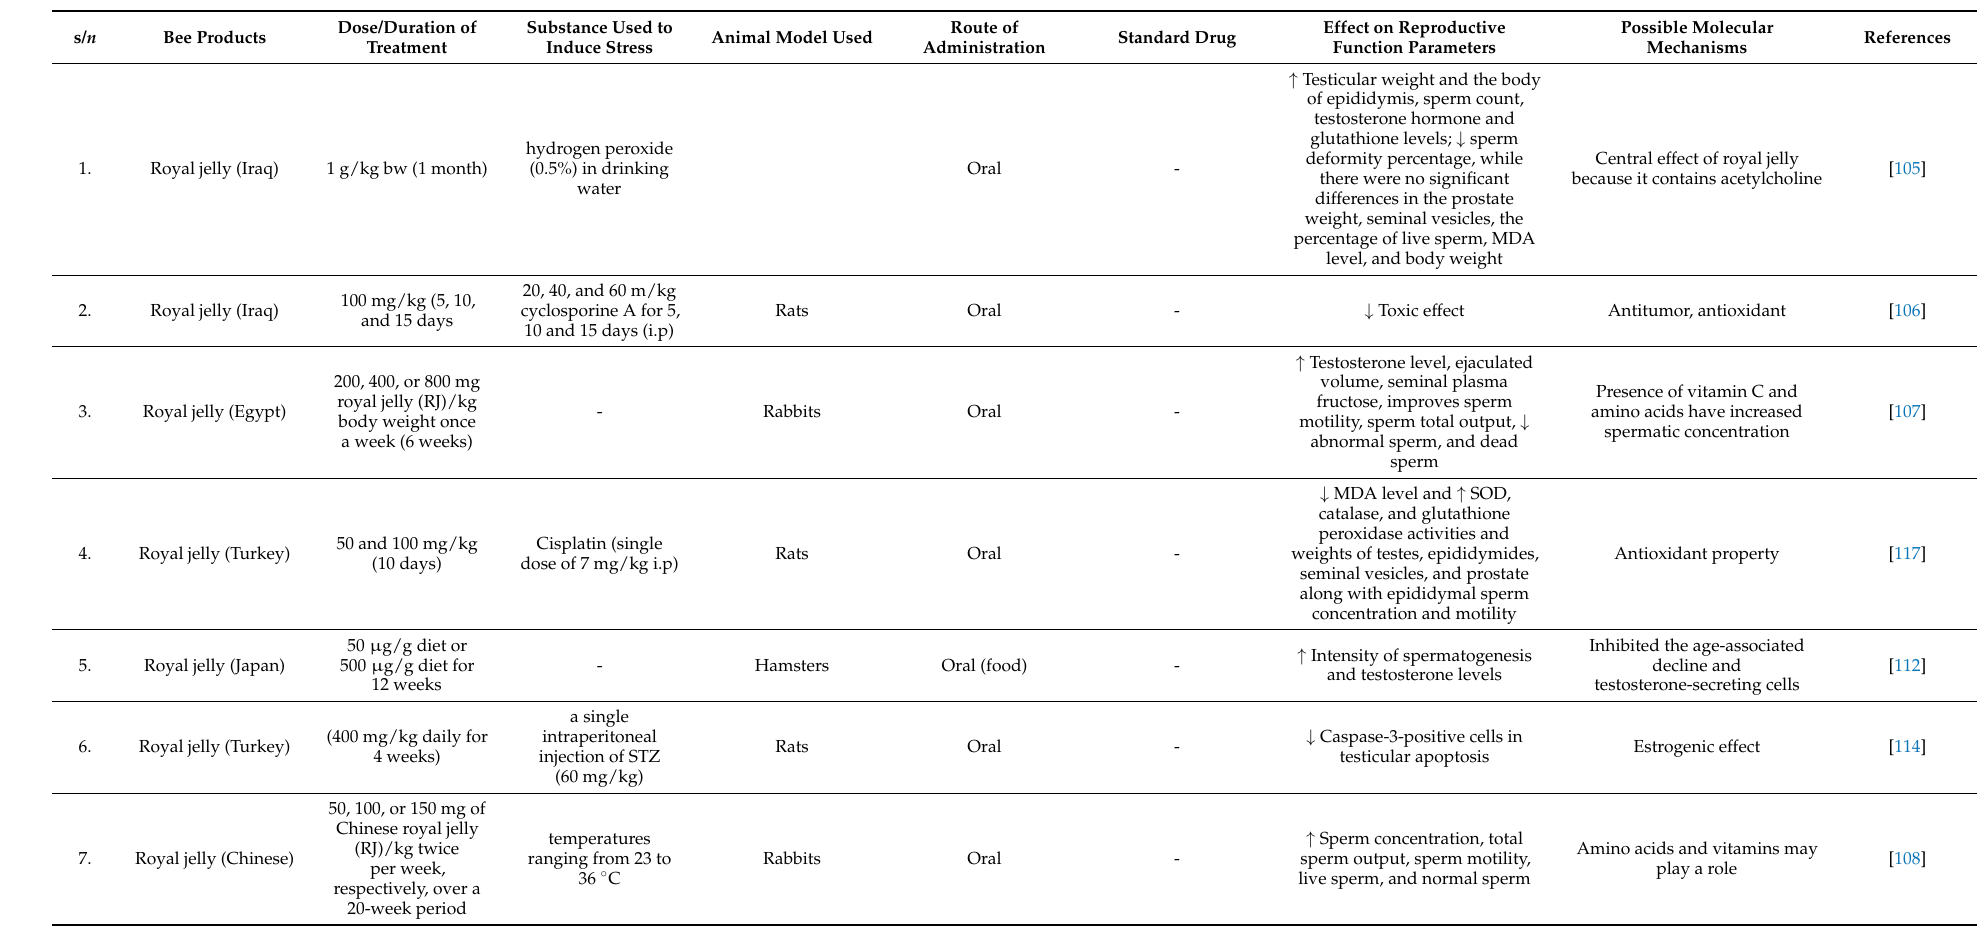
Table 5. Effects of royal jelly on male reproductive